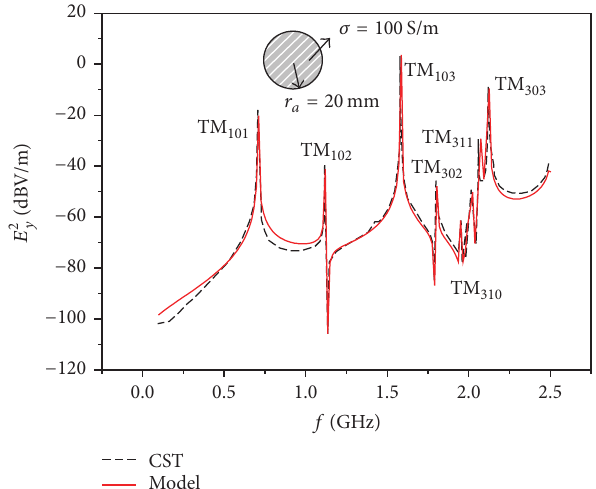
Figure 4: Component of electric field 𝐸 2 𝑦 at ( 150, 60, 150 )mm for a covered circular aperture from the analytical model and the CST. Figure 5: Electric current induced at termination load